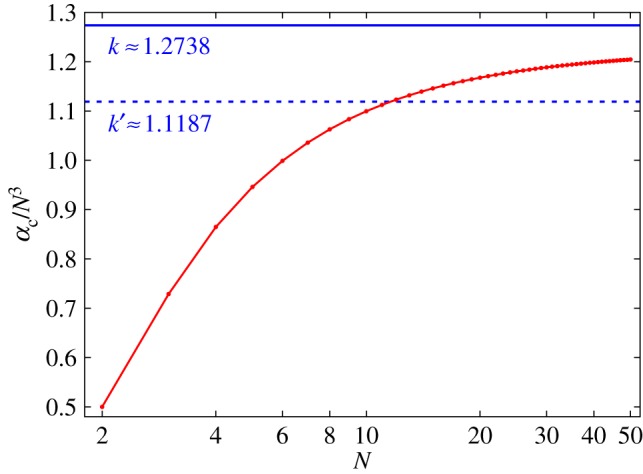
Critical value αc (red curve) as in figure 5. The plot is scaled by N3. The solid blue line shows the critical asymptote αc∞ (4.12) for N→∞ with the prefactor k from (4.13) obtained under the assumption of only local magnetic interactions. The dashed blue line is an asymptote analogue to (4.12) with the prefactor k′ obtained from Vella et al. [10].